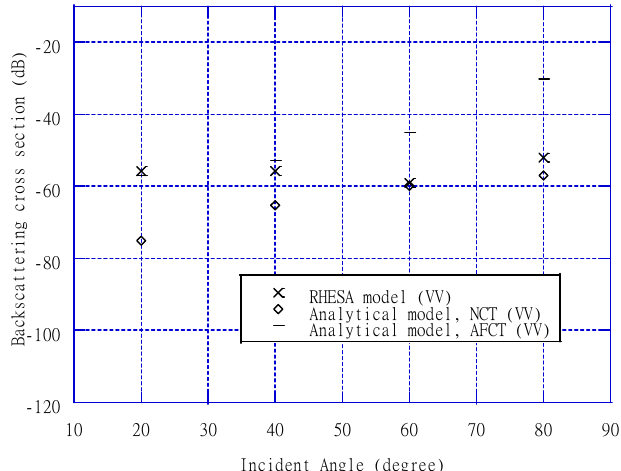
Figure 5. Comparison between theories for backscattering cross section of an elliptical disc scatterer against ka, at an incident angle of 20 degrees.